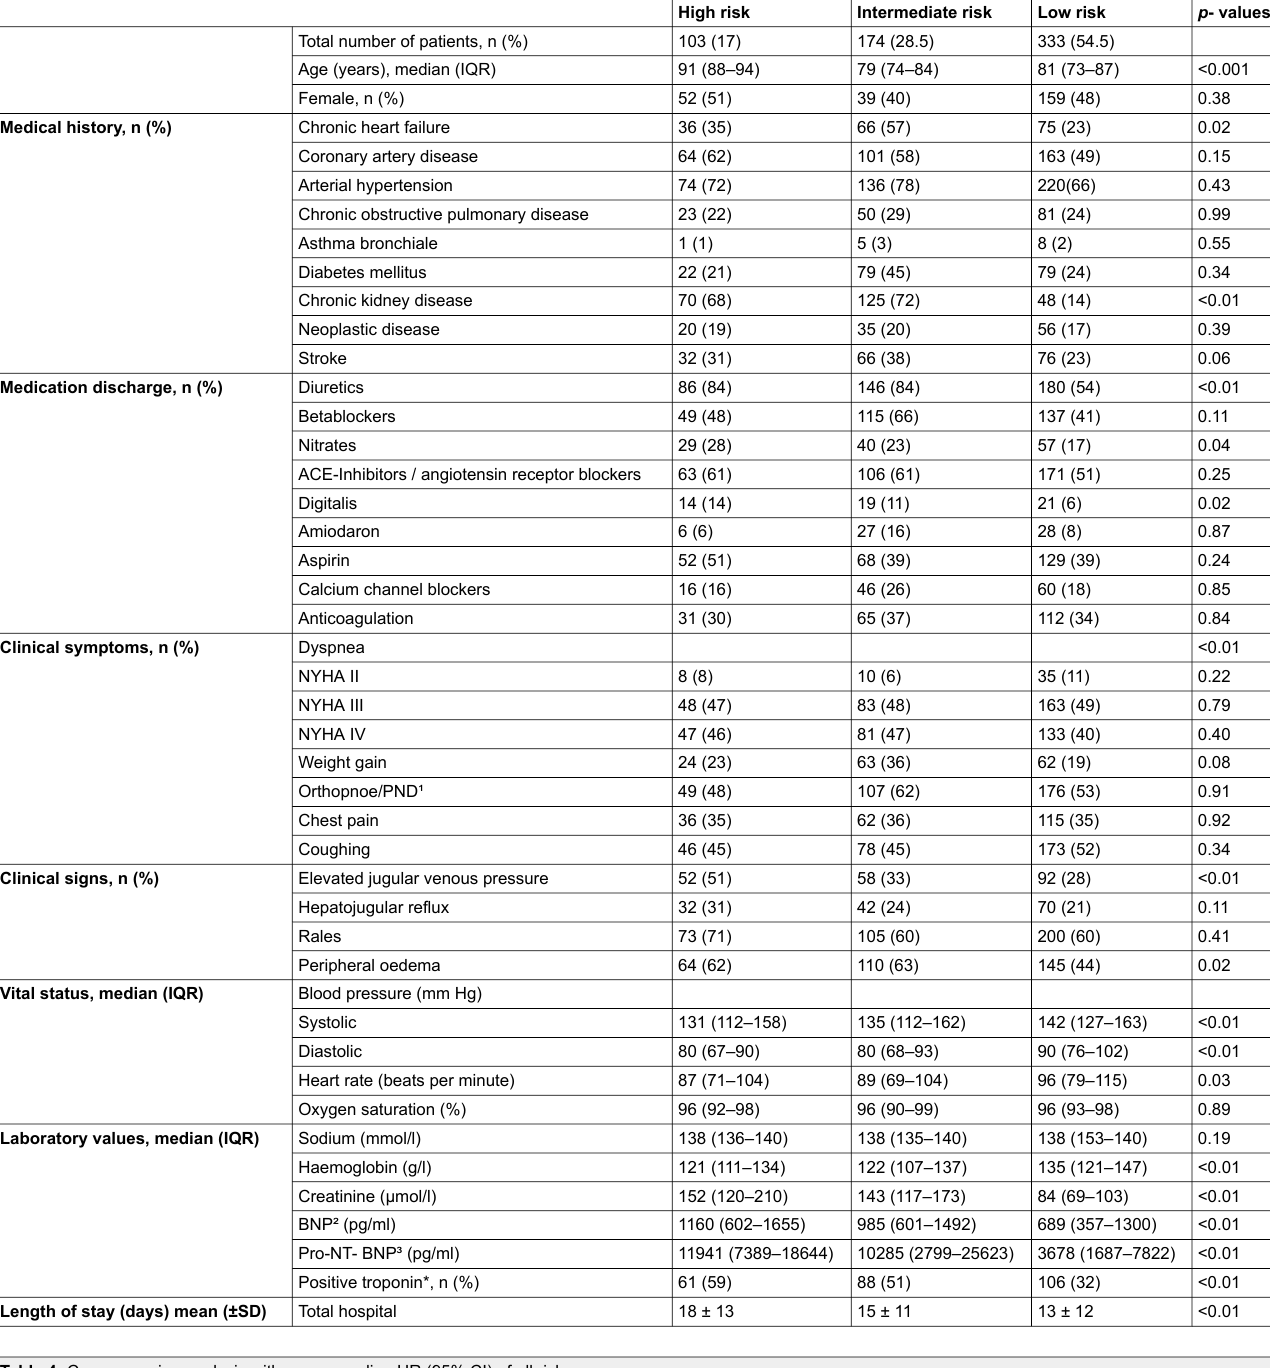
Table 3: Demographic and clinical characteristics of risk groups.